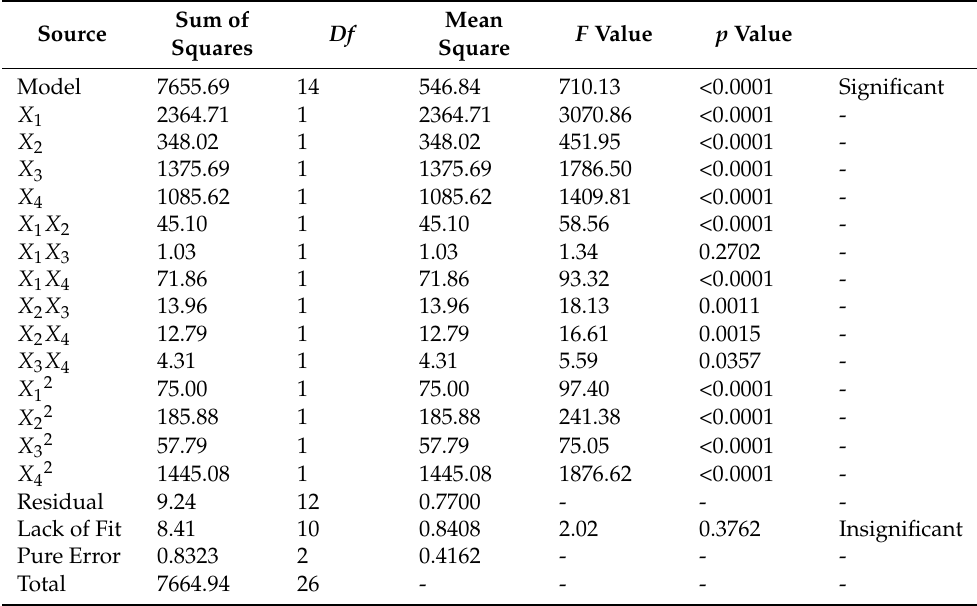
Table 4. ANOVA of the BBD quadratic polynomial model for photocatalytic degradation of MO using Gd 2 O 3 -ZIF-8